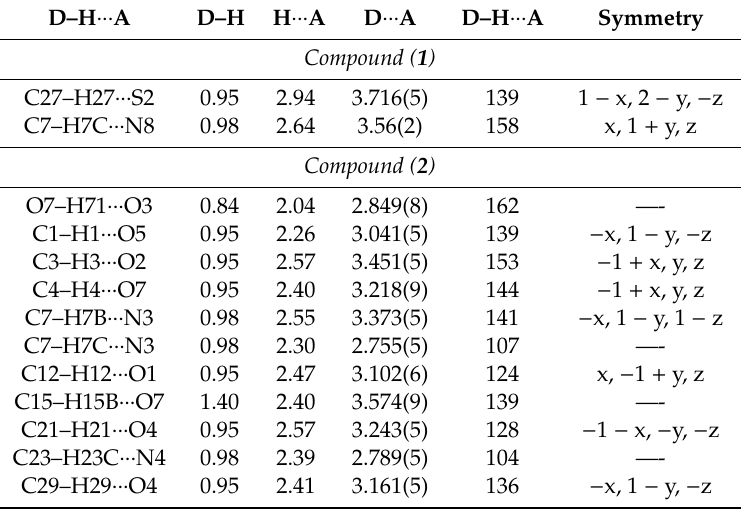
Table 3. Relevant hydrogen bonding parameters of compounds ( 1 ) and ( 2